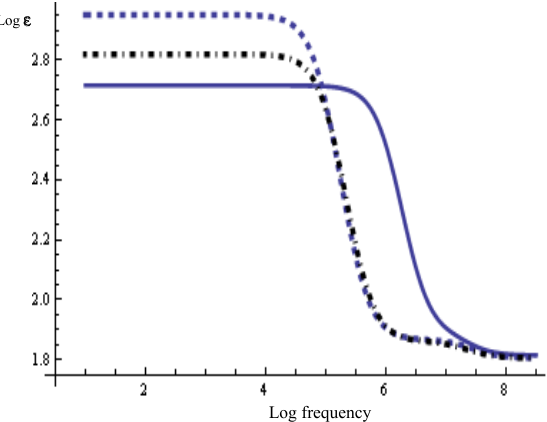
Fig. 3.A: Permittivity spectra for suspensions of charged liposomes: σ 3 = 0.377 S/m & D 3 = 5×10 -9 m 2 /s (solid); σ 3 = 0.377 S/m & D 3 = 5×10 -10 m 2 /s (dashed); σ 3 = 0.1 S/m & D 3 = 5×10 -10 m 2 /s (dot-dashed)